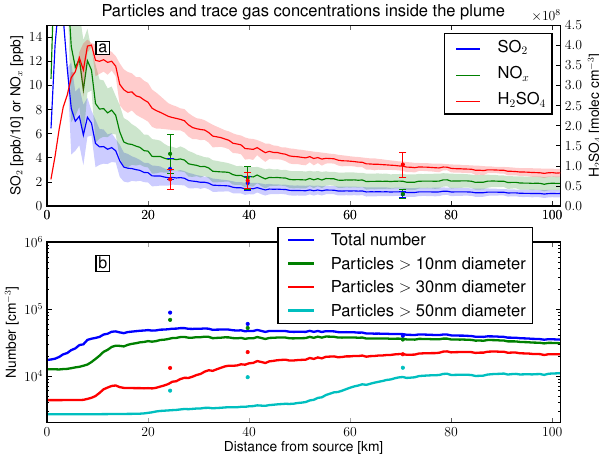
Fig. 6. (a) Trace gases and (b) particle number versus dis- tance downwind from the Conesville power-plant, averaged over the plume. Dots are aircraft observations; lines are model re- sults. Shaded area and error bars indicate one standard devia- tion in concentration across plume width. Model resolution is 800 × 800 ×